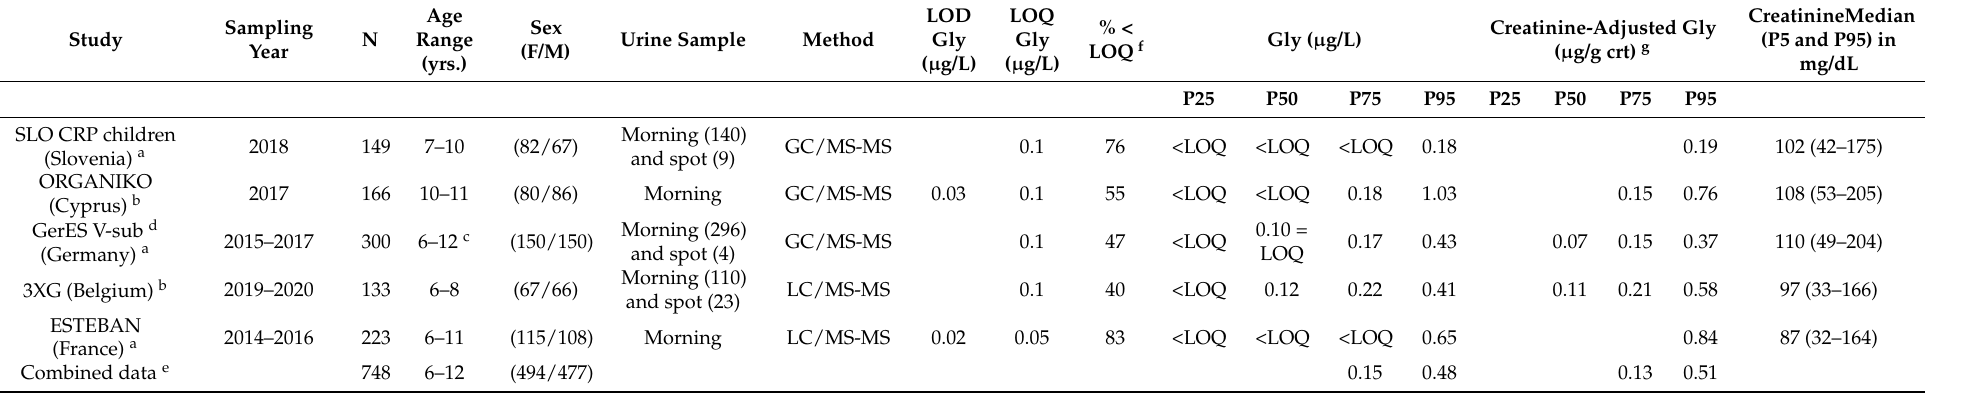
Table 1. Urinary Gly concentrations in European children (6–11 yrs.) from HBM4EU-aligned